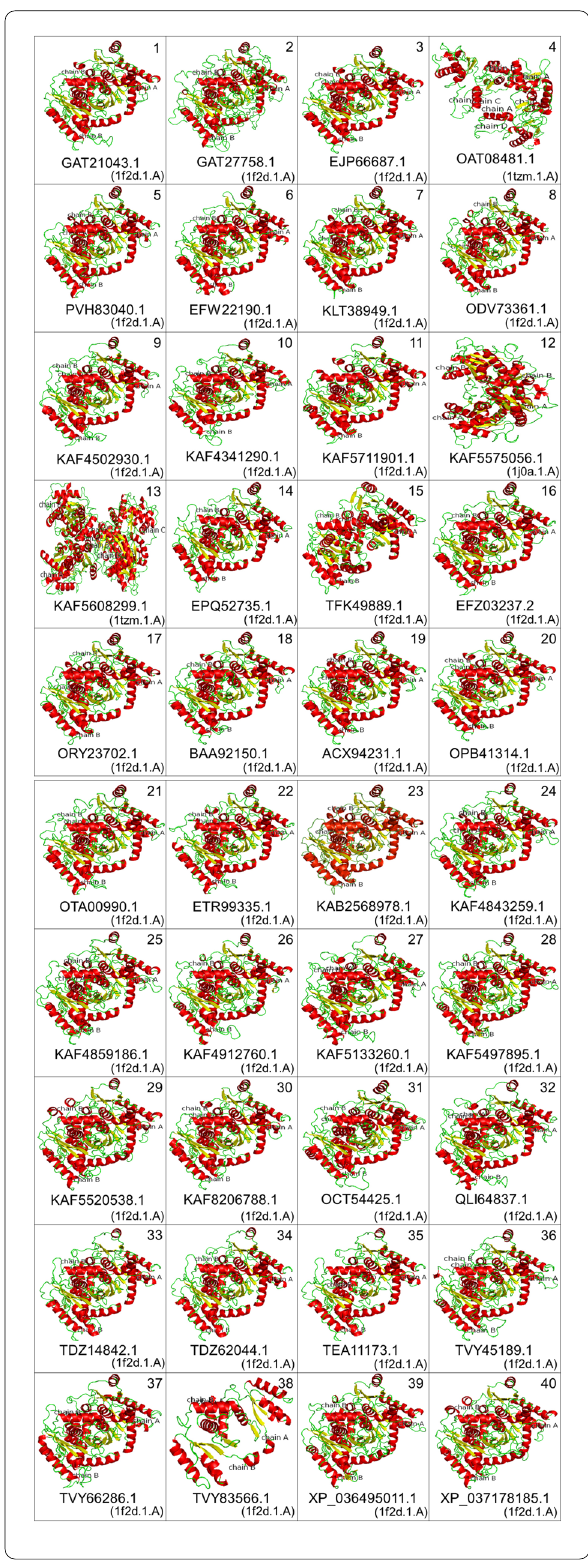
Fig. 4 Three-dimensional models of fungal ACC deaminases (red helix, yellow sheet, green loop). Templates for each model = = = are in